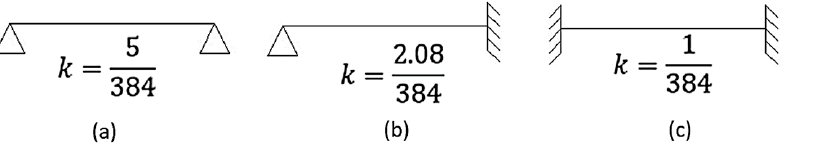
Figure 10. k coefficient for ( a ) simply supported slab, ( b ) supported fixed-ended slab and ( c ) fixed- ended slab.